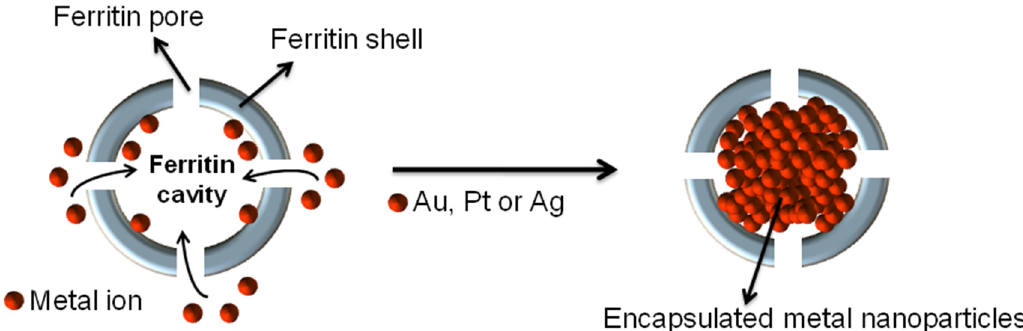
Figure 1. Summary of the synthesis of metal-containing human ferritin H chain (HFt)-based nanocarriers.